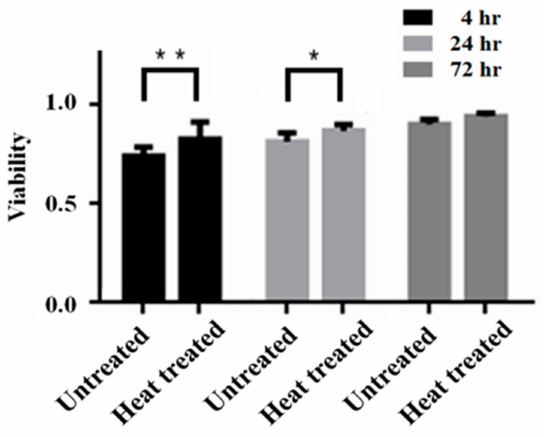
Figure 7. Determination of cell viability by an MTT assay. The MTT assay was performed to evaluate cell viability of osteoblast-like human MG-63 cells attached to untreated and heat-treated Ti64 substrates after 4, 24, and 72 h of incubation ( n = 5, *, p < 0.05; **, p <